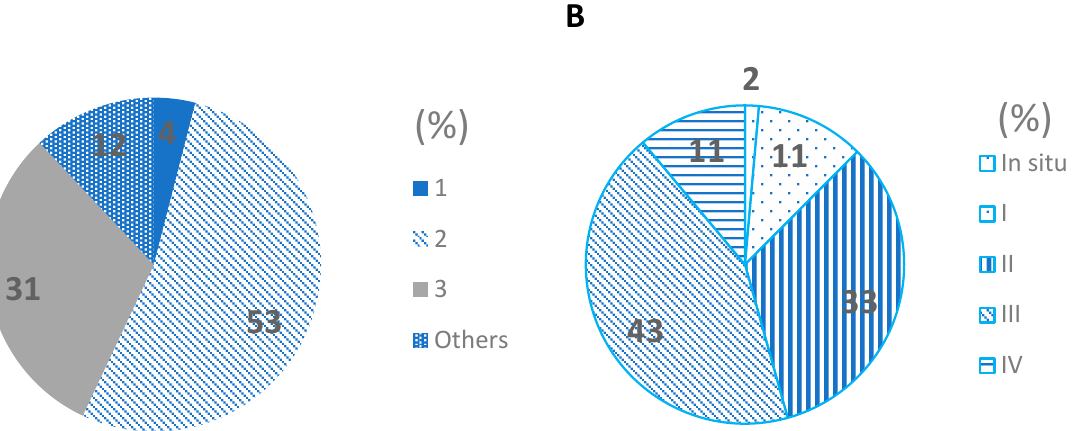
Figure 2. Percentage distribution of tumor grade of breast cancer in Mexican women ( A ). Percentage distribution of stage clinical of breast cancer in Mexican women ( B ).